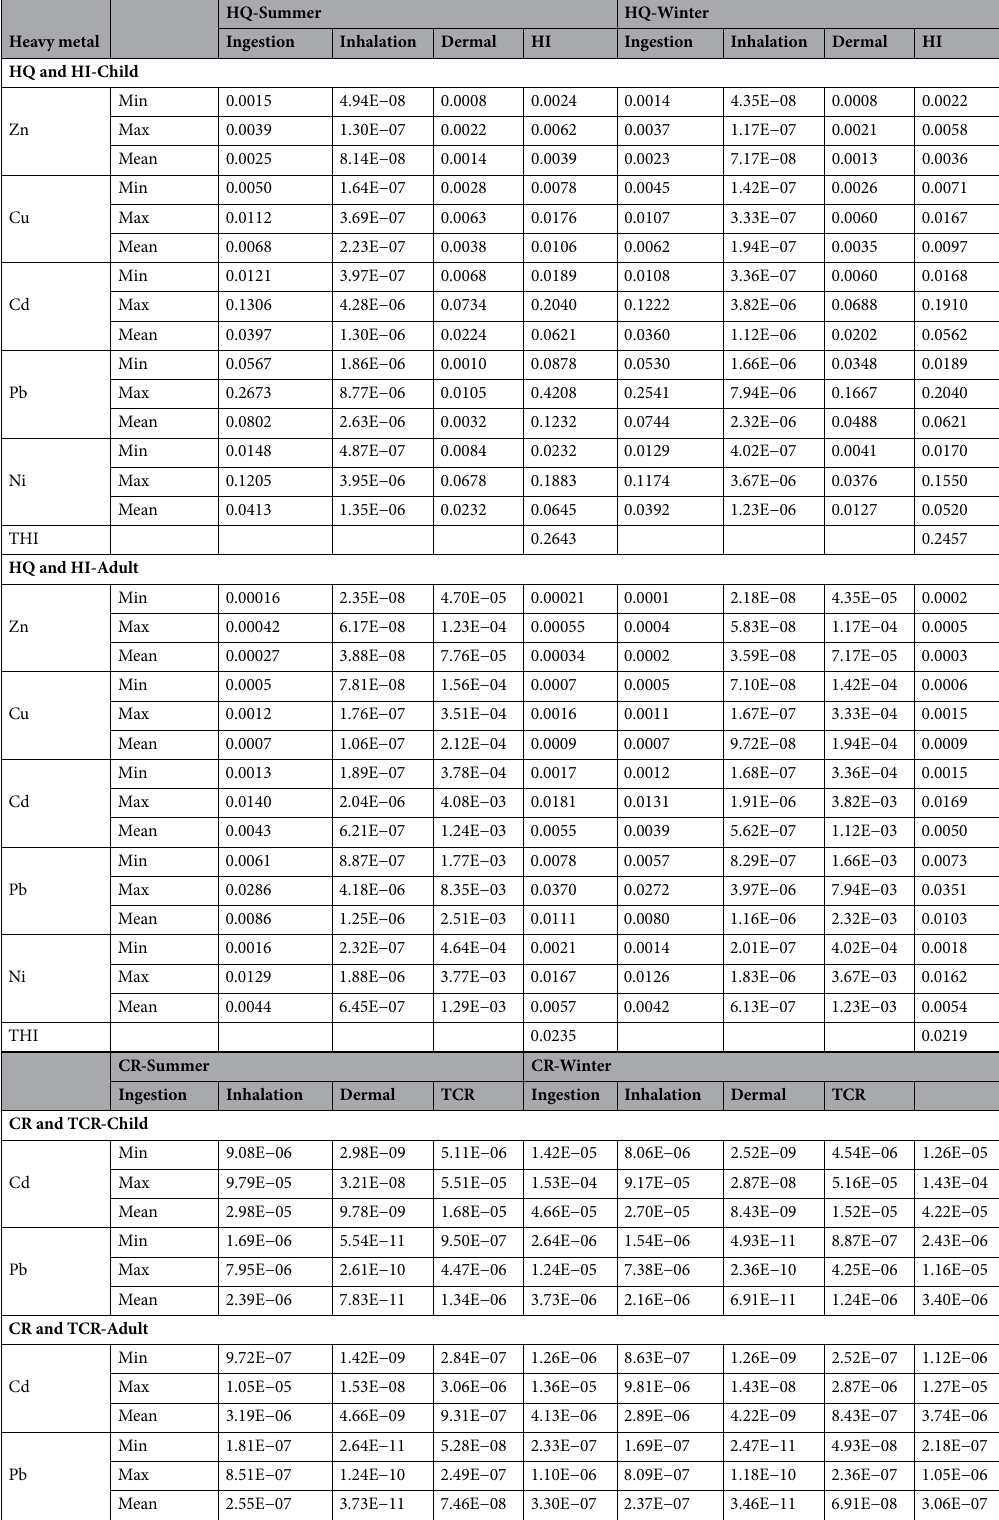
Table 6. The minimum, maximum, and mean values of HQ, HI, CR, and TCR of heavy metals from ingestion, inhalation, and dermal contact of